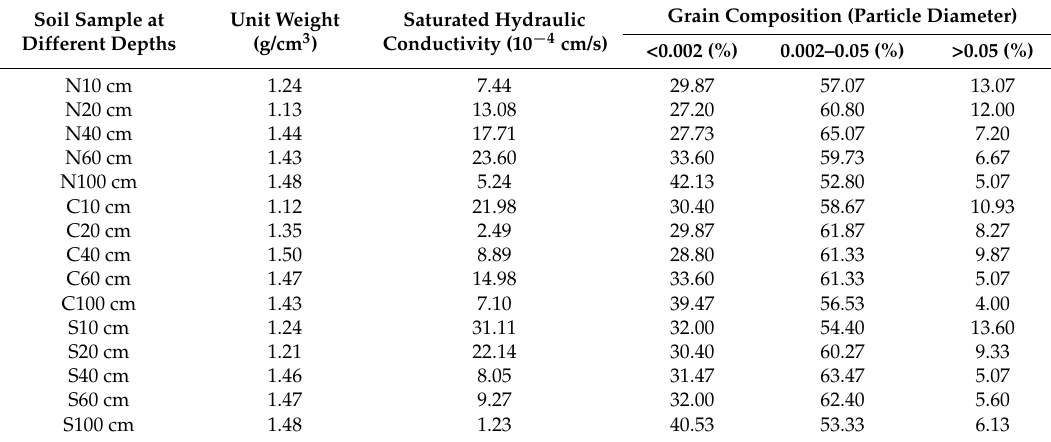
Table 1. Physical properties and grain composition of soil samples at different depths in the north, center and south of the experimental